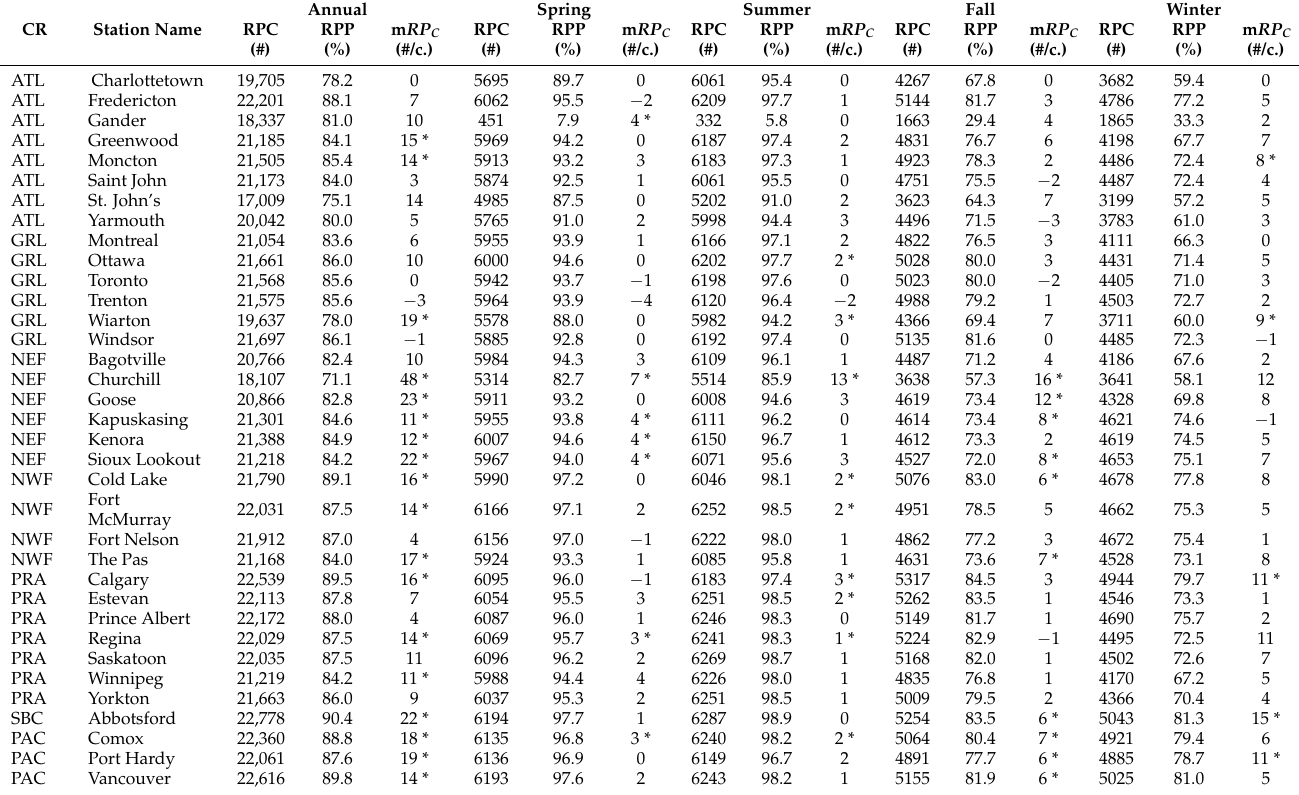
Table 2. Radiative population counts, radiative population participation, and radiative population slope of counts reported per century (#/c.) “m” represents “slope”. RPC—Radiative Population Count, RPP—Radiative Population Participation, and m RP c —Slope of Radiative Population Count. “CR” represents “climate region”. ATL—Atlantic Canada, GRL—Great Lakes/St. Lawrence